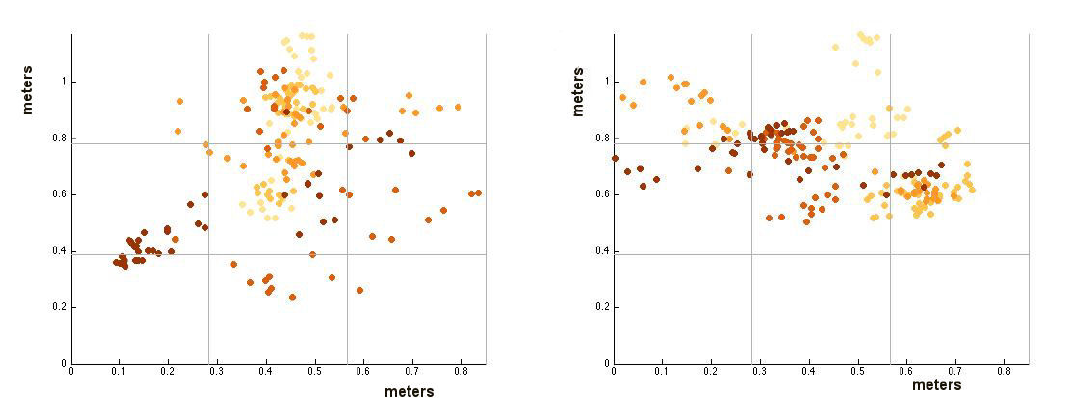
Figure 10. The computed hit-map for Children #1 (left) and #2 (right).